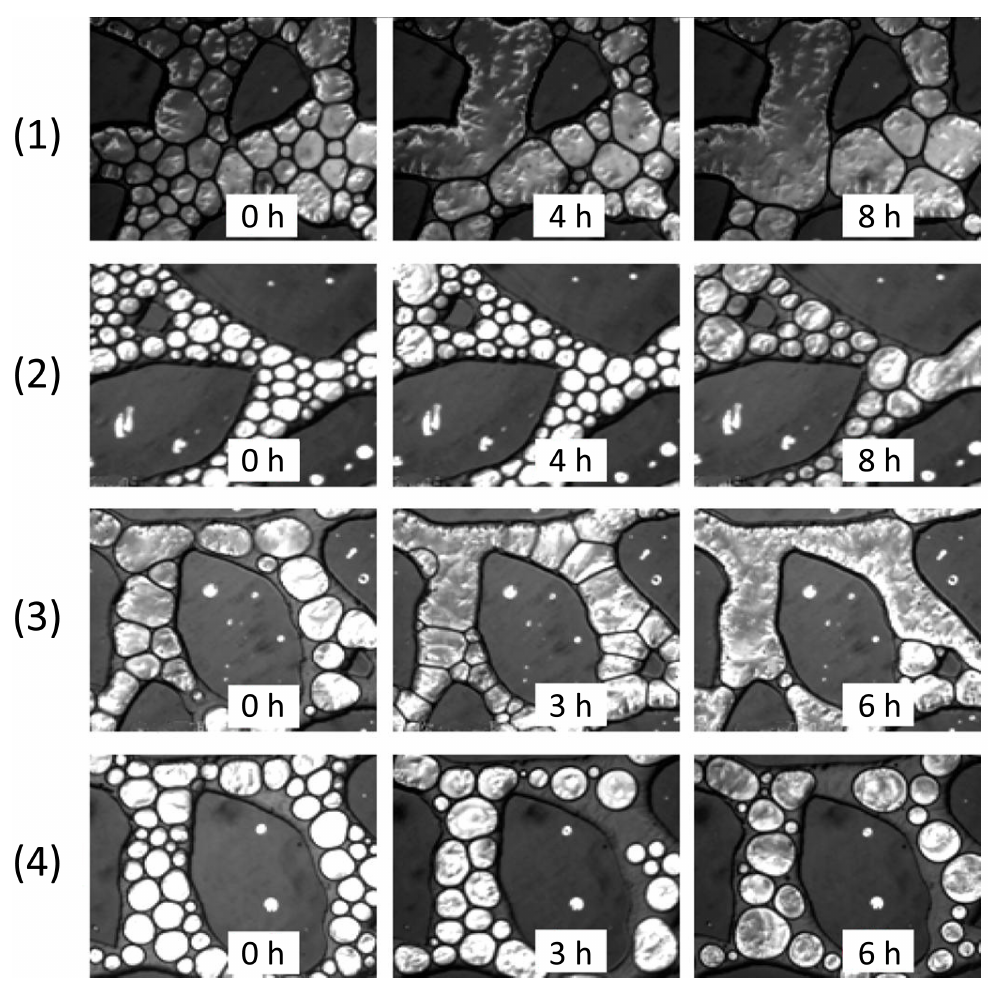
Figure 21. Behavior of foams at different temperatures and as a function of time: ( 1 ) SDS at 60 °C,